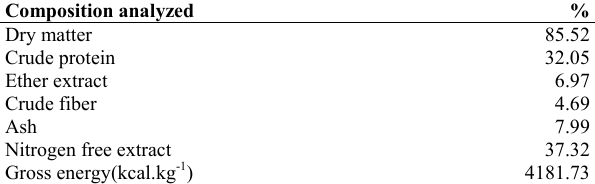
Table 1. Diet reference ingredient composition